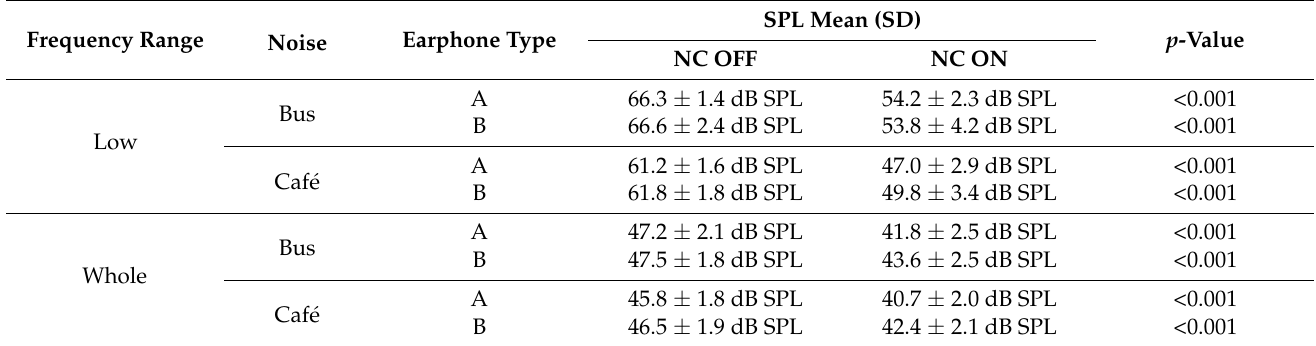
Table 1. NH group’s mean and standard deviation of SPLs for the two types of earphones in bus and caf é noises.